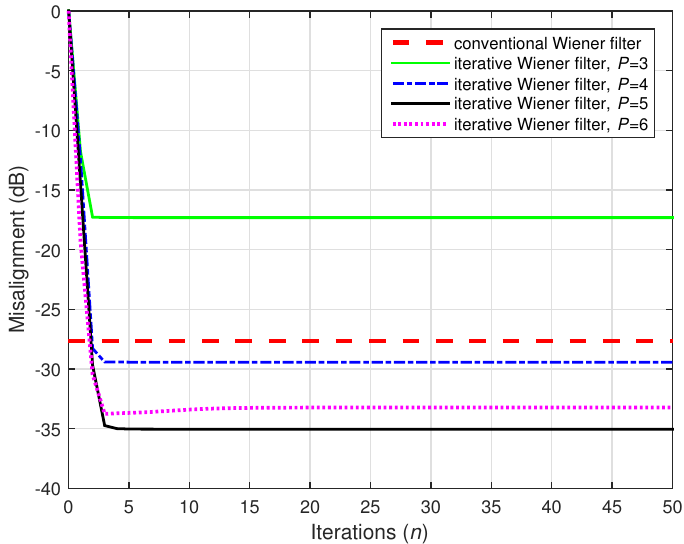
Figure 8. Performances of the conventional and iterative Wiener filters, using N = 10,000. The input signals were independent AR(1) processes, M = 4, L = 500, and SNR = 30 dB.